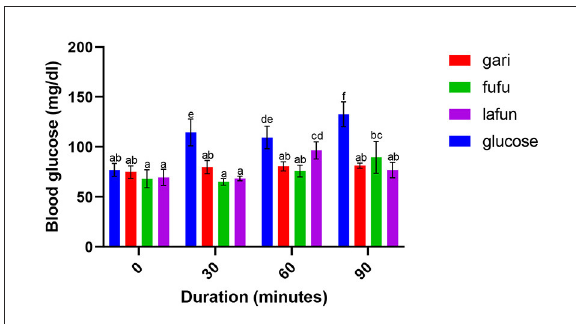
FIGURE2 Blood glucose response after the intake of fufu, lafun and gari from IITA-TMS-IBA070337. Mean values with different letters are significantly different at p < 0.05.